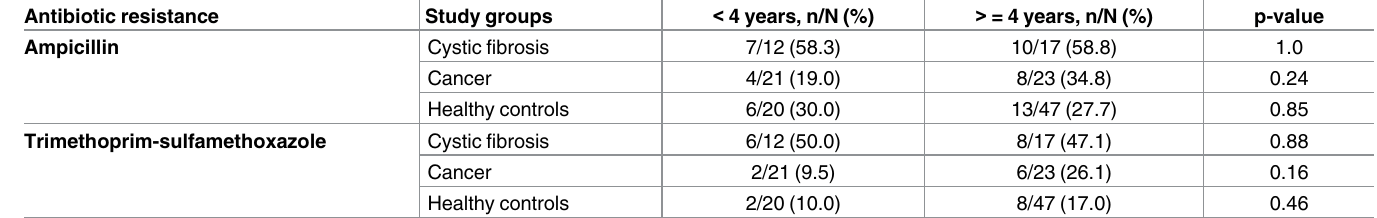
Table 4. Prevalence of ampicillin-resistant and trimethoprim-sulfamethoxazole-resistant E . coli in faecal samples from two age groups (younger or older than 4 years)of patients with cystic fibrosis, cancer and healthy controls (first study sample). Antibiotic resistance